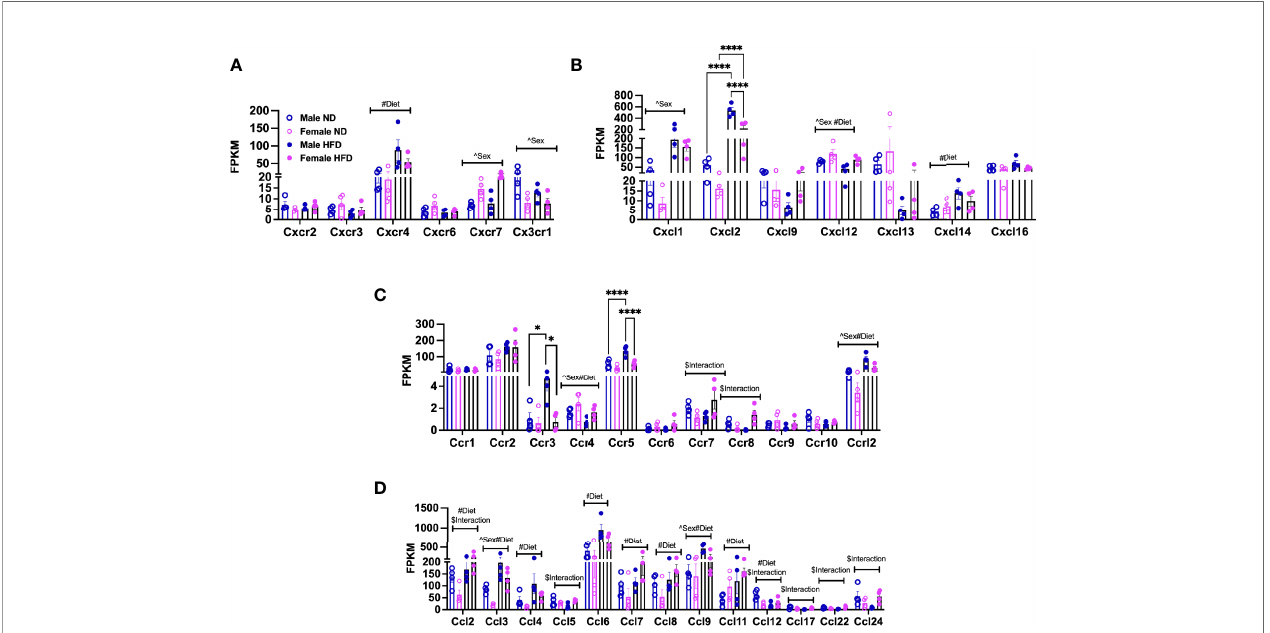
FIGURE 3 | Sex differences in gene expression of ATM receptors and ligands. FPKM counts from single-cell RNA-seq data showing gene expression of (A) chemokine receptors, (B) chemokine ligands, (C) chemokine (C-C motif) receptors, and (D) chemokine (C-C) motif ligand. N = 4 per group. Data were analyzed by 2-way ANOVA followed by Tukey ’ s multiple comparisons test. Data shown as average +/- SEM. *p < 0.05, and ****p < 0.001. Figures are marked for signi fi cance of main effects (^sex or #diet) and